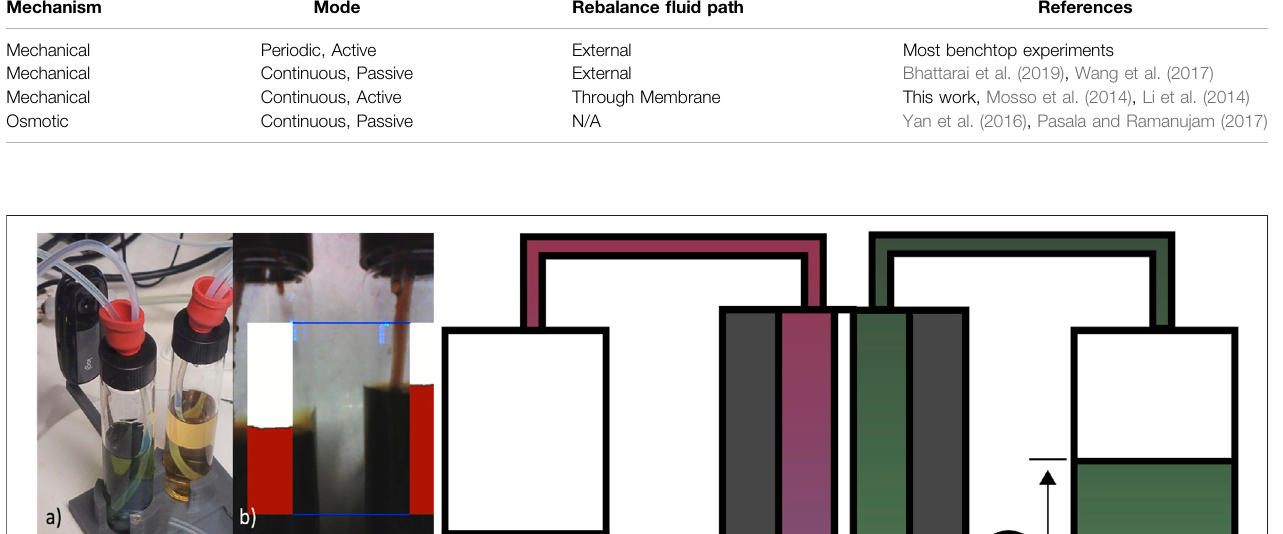
Frontiers in Chemical Engineering |